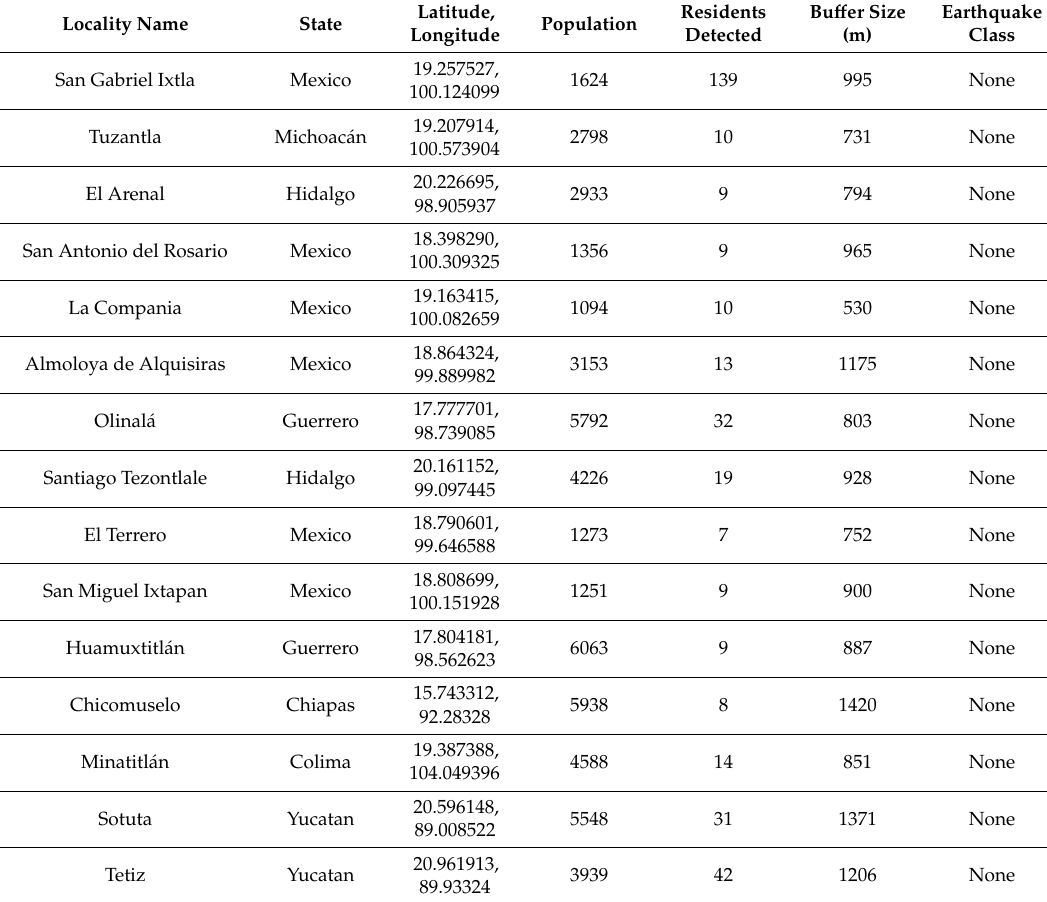
Table A2. Fifteen control localities were used in the final analysis. In processing, an additional 610m was added to this bu ff er radius to account for privacy data screening by the data